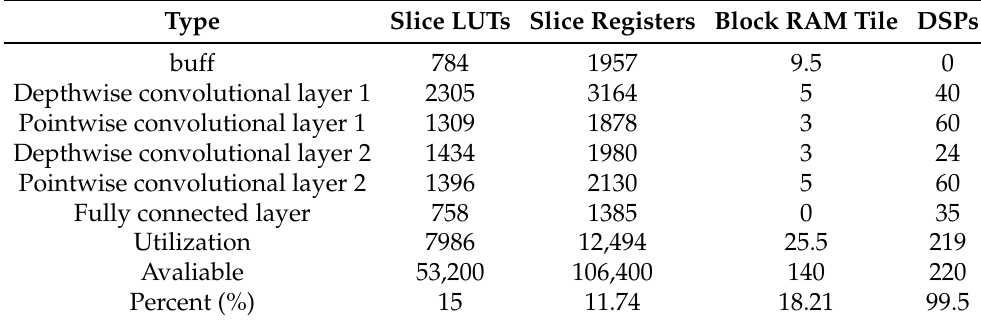
Table 7. Resource utilization of OI-DSCNN on